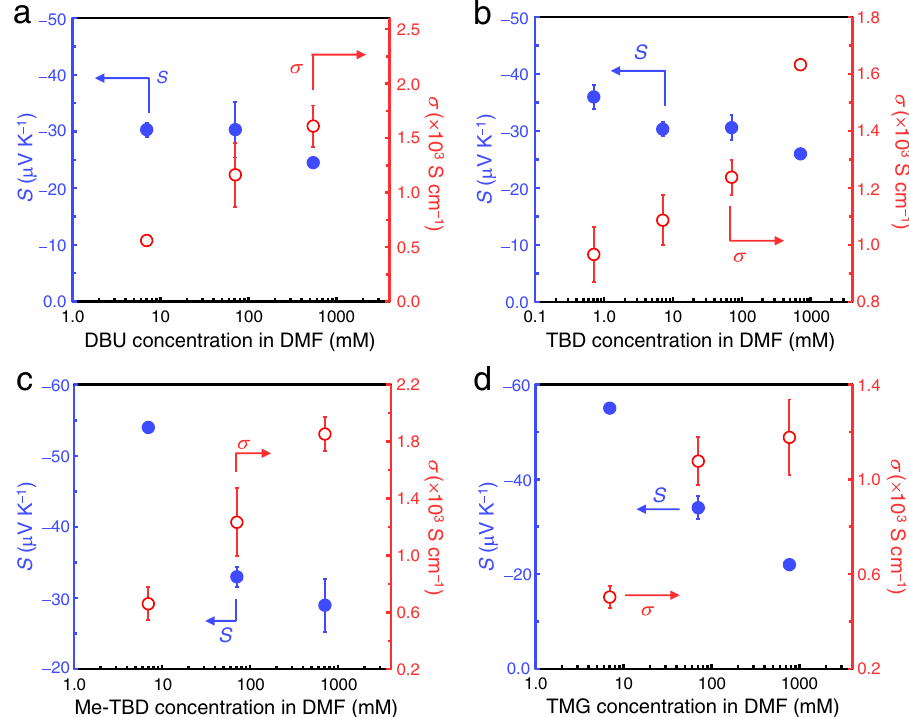
Fig. 3 Dopant-concentration-dependent Seebeck coef fi cient ( S ) and electrical conductivity ( σ ). n-Type specimens were prepared by immersing EC1.5- indicate S and σ , respectively. Data statistics: n ≥ 3. Error bars indicate the corresponding standard deviations